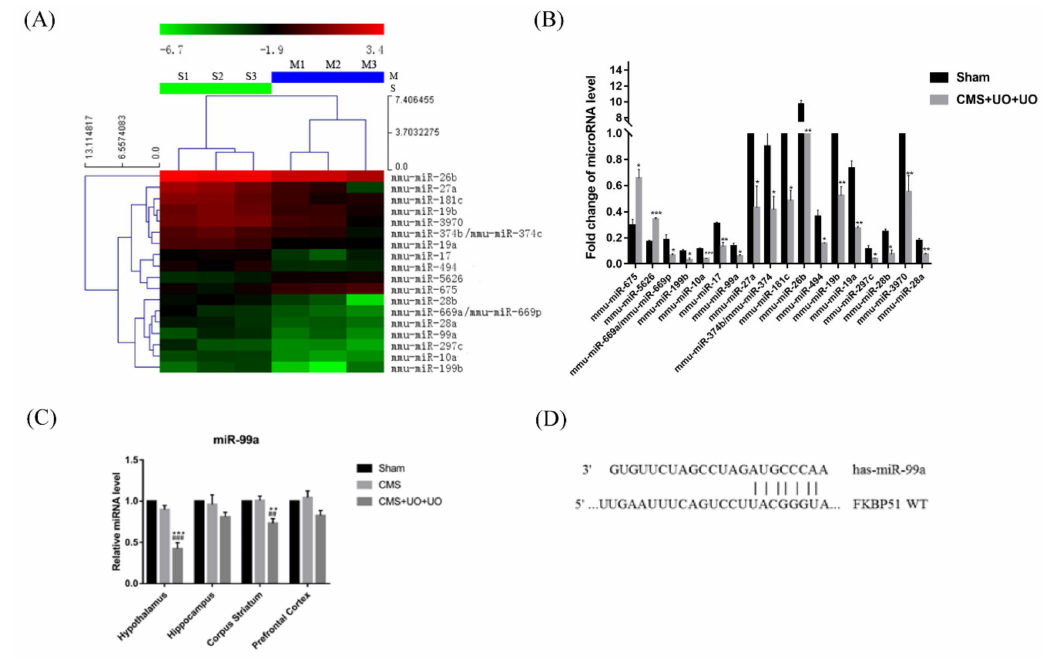
Figure 3. The expression level of miR-99a was downregulated in the hypothalamus of peri / postmenopausal depressive mice. ( A ) The microRNA (miRNA) expression profile analyzed by a miRNA chip between the sham group and the CMS + UO + UO model. ( B ) Quantification of miRNAs in the two groups screened from the chip. ( C ) The miR-99a expression levels in the hypothalamus, hippocampus, corpus striatum, and prefrontal cortex were detected by quantitative reverse transcription-polymerase chain reaction (qRT-PCR). ( D ) MiR-99a bonds to the 3 (cid:48) UTR of FKBP51. Data are presented as means ± SEMs, n = 4–5, * p < 0.05, ** p < 0.01, *** p < 0.001 versus